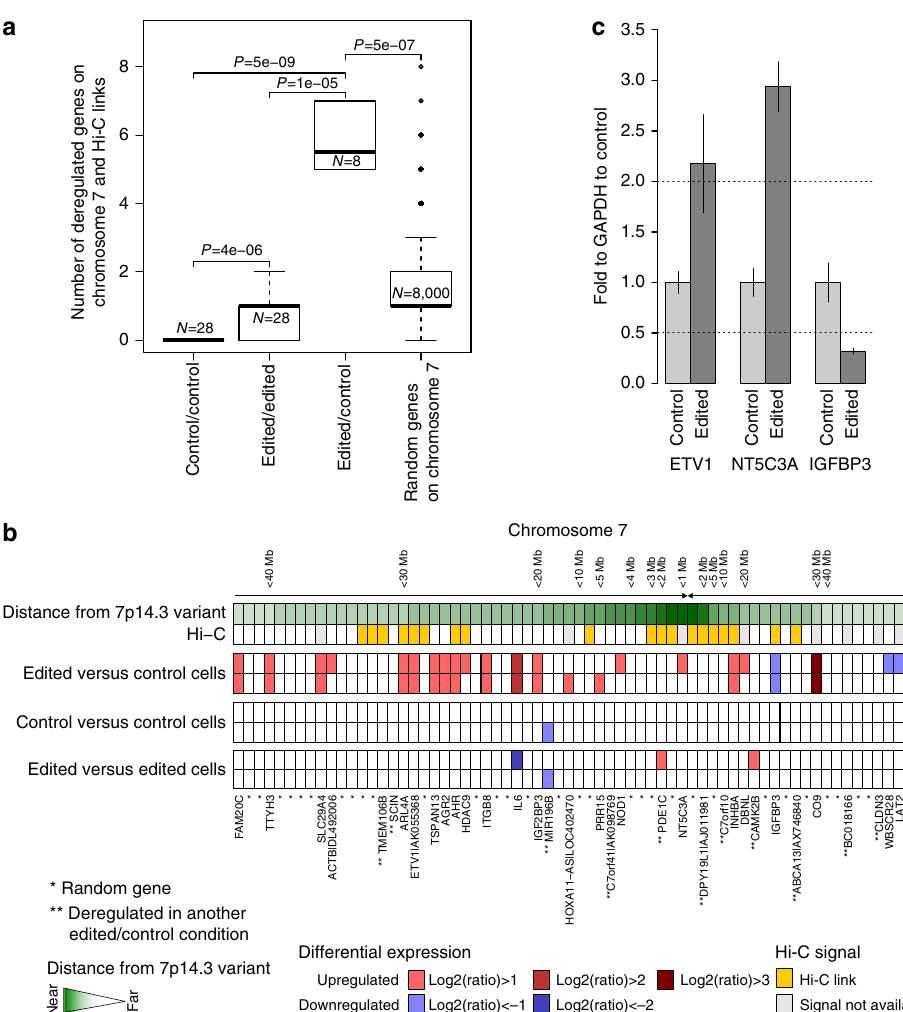
Fig. 3 Transcriptome of 7p14.3 locus deleted cells. a Deregulation of transcripts on chromosome 7 with respect to prostate cells Hi-C identi fi ed links. Enrichment is shown by comparing the level of deregulation in edited vs. control cells, in edited vs. edited, and in control vs. control cells. Further, enrichment is shown by comparing the level of deregulation in edited vs. control cells with simulated data computed by generating, for each tested combination, 1000 random selections of genes at chromosome 7 with size equal to the observed deregulated set. P -values are computed using Mann – Whitney test. b Visual representation of deregulation patterns in edited vs. control cells at chromosome 7 within a 40 Mb window around the 7p14.3 variant. Representative experimental conditions of edited vs. control cells are shown and random combinations of edited vs. edited and control vs. control cells are shown. c Real-time PCR validation of selected genes nominated by RNA-seq, ETV1, NT5C3A, and IGFBP3; dotted lines represent fold thresholds applied in RNA-seq analysis to identify deregulated transcripts (additional data and negative controls in Supplementary Fig. 12). Data are represented as mean ± s.d. of three technical